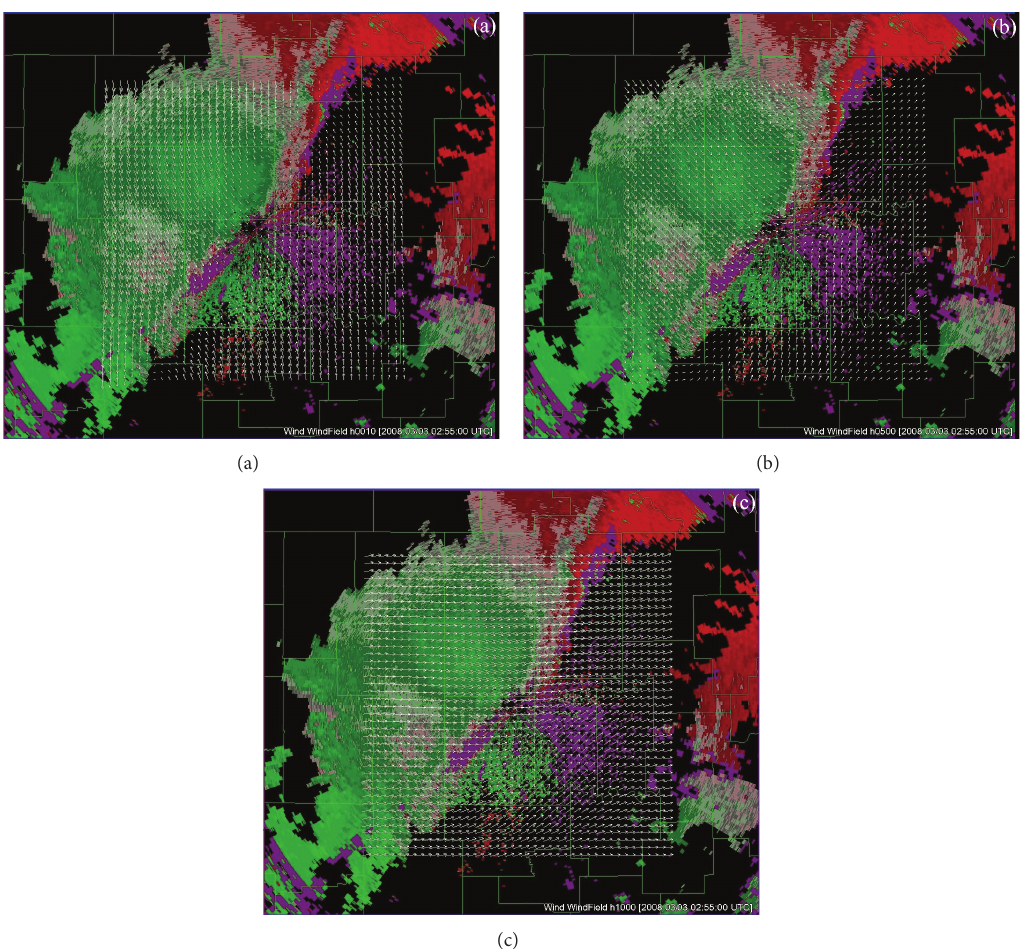
Figure 3: Horizontal wind fields produced by the stand-alone RWAS at 𝑧 = 10m in (a), 𝑧 = 500 m in (b), and 𝑧 = 1km in (c) for the mesoscale front moved into the analysis domain at 025500 UTC on March 3, 2008. The color image in each panel shows the dealiased radial velocities at 0.5 ∘ tilt from the KTLX radar. The vector scale is the same for the three panels and is plotted at the lower-left corner of (b). The analysis domain size is 160 × 160 × 3km 3 . The horizontal resolution is Δ𝑥 = Δ𝑦 = 2km and the vertical resolution is Δ𝑧 = 250 m. The radial-velocity color scales are the same as those shown on the top of each panel of Figure 4. The green lines plot the county boundaries